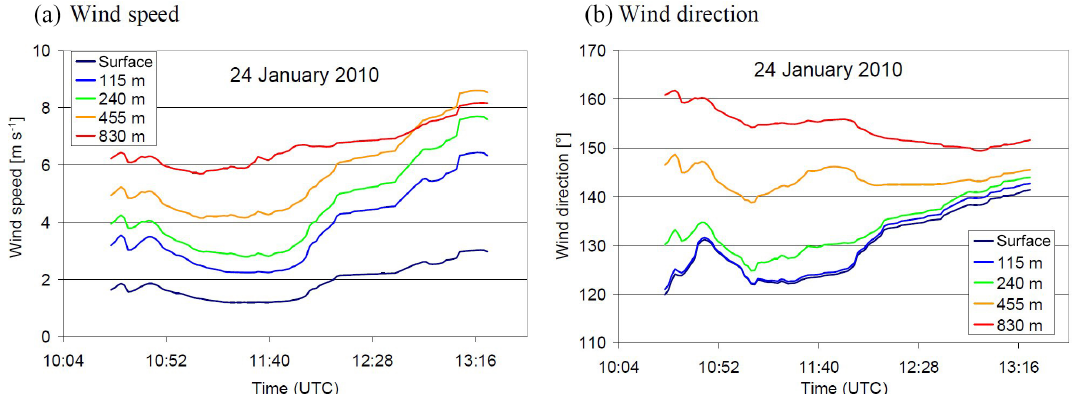
Figure 3. Wind speed (a) and direction with respect to north (b) at different altitudes for 24 January 2010 obtained from the MM5 model during the time of measurement of the entire single circle.